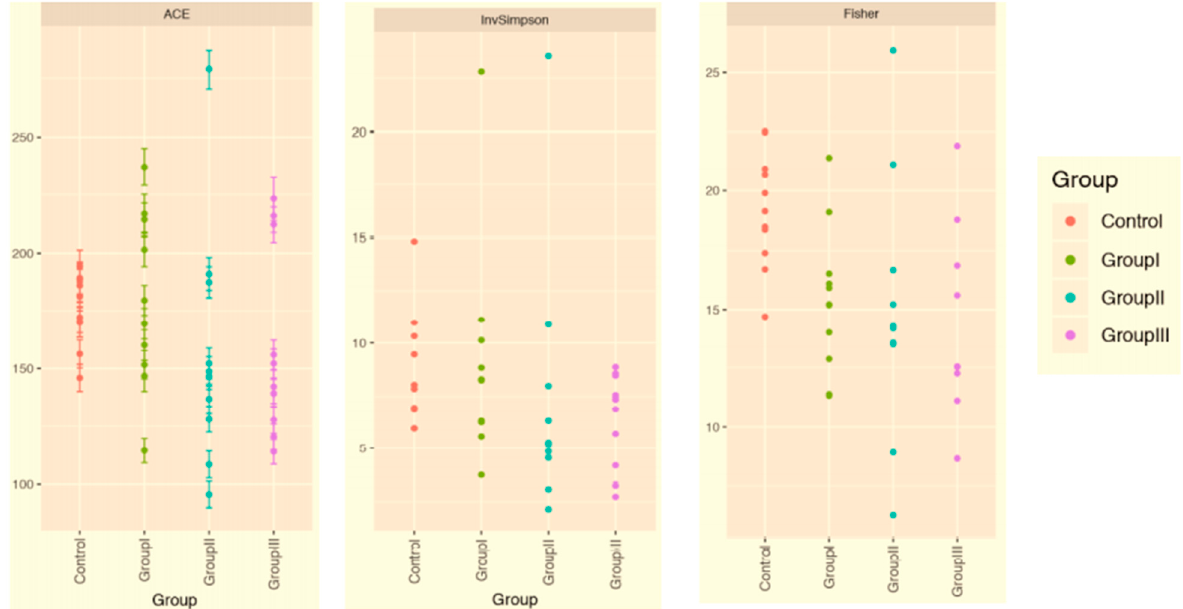
Figure 1. Alpha diversity of the gut microbiota of COVID-19 and healthy subjects. Control: non-COVID-19 subject; Group I: asymptomatic group; Group II: mildly infected group; Group III: severely infected group.